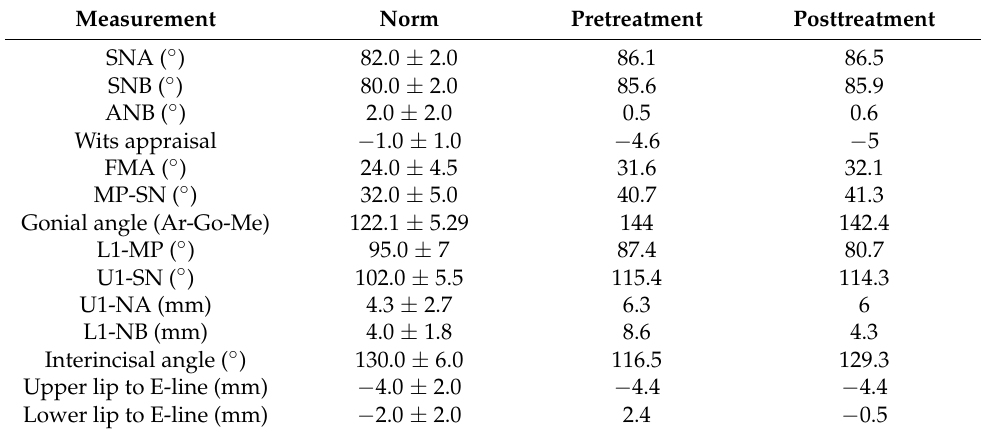
Table 1. Cephalometric analysis.